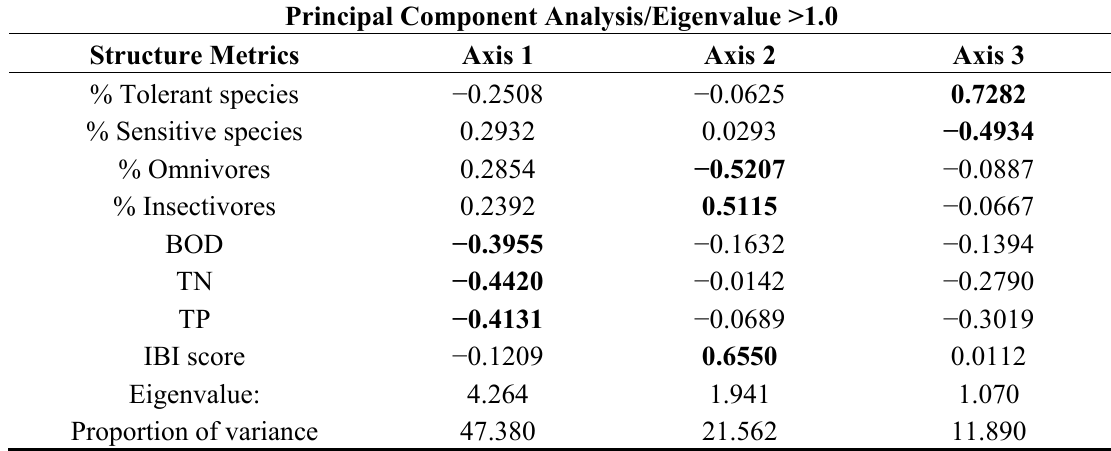
Table 1. Principal component analysis (PCA) based on biological and chemical variables. Bold values indicate statistically significant in the level of